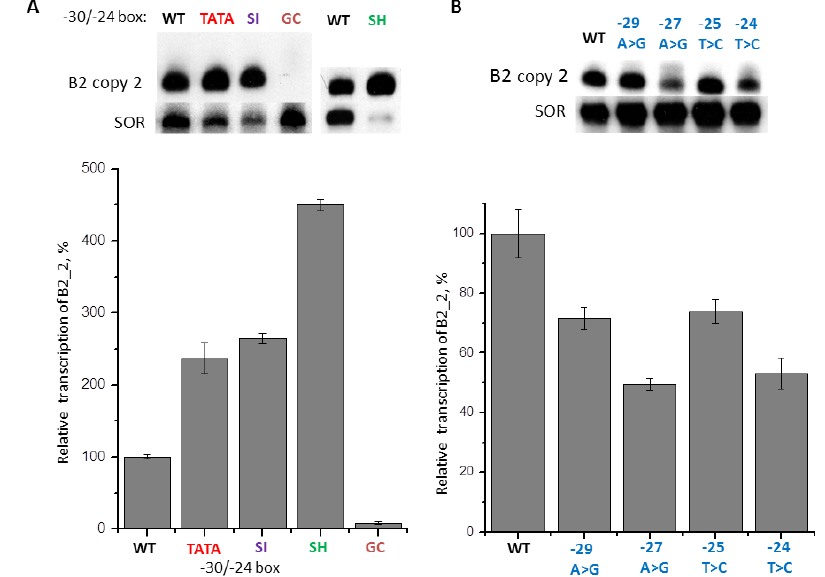
Figure 10. ( A ) B2_2 transcription is modulated by replacement of the − 30 / − 24 sequence by TATA box, boxes − 31 / − 24 of 4.5SI RNA and 4.5SH RNA genes, and GC-rich heptamer. The transcription level of B2_2 with the intact 5 (cid:48) -FS (WT) is taken as 100% (error bars, SD, n = 3). ( B ) Effect of single-nucleotide substitutions in the − 30 / − 24 region of B2_2 copy on its transcription. Substitutions and their positions are indicated above the lanes and on the diagram (error bars, SD, n =